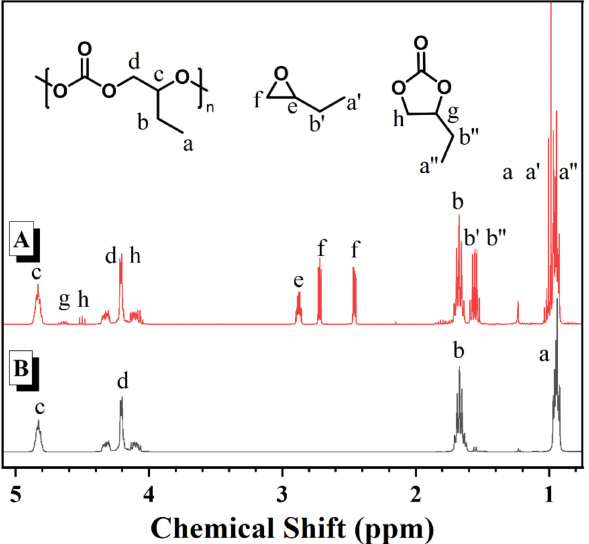
Figure 1. 1 H NMR spectra of crude products ( A ) and purified products ( B ) of PBC (Table 1, entry